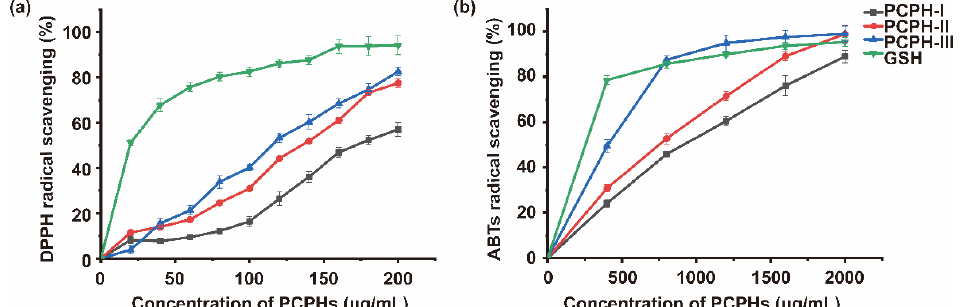
Figure 1. Antioxidant activities of hydrolysates obtained by ultrafiltration. ( a ), DPPH radical scavenging capacity of protein hydrolysate fraction of pecan cake by ultrafiltration with MW > 10 kDa (PCPH-I), 3 − 10 kDa (PCPH-II), and <3 kDa (PCPH-III). ( b ), ABTS radical scavenging capacity of protein hydrolysate fraction of pecan cake by ultrafiltration with MW > 10 kDa (PCPH-I), 3 − 10 kDa (PCPH-II), and <3 kDa (PCPH-III). The data shown are mean ± SD ( n = 3).